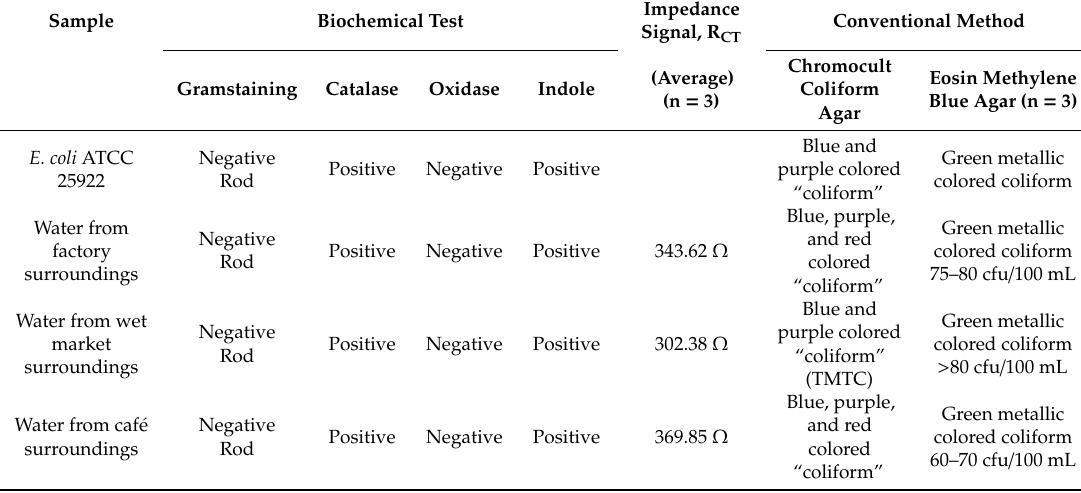
Table 2. Real samples measured with conventional methods and the hybridized label-free DNA biosensor. Sample